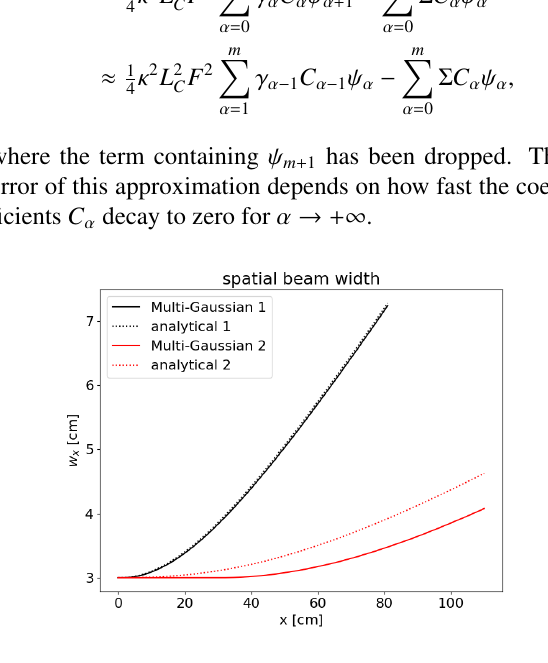
Figure 2. Evolution of the spatial width w x of the beam along the propagation axis x = τ . Comparison of the multi-Gaussian solu- tion (26) and the analytical reference (10) for two sets of fluctu- ation parameters. Beam parameters: initial width w x (0) = 3cm, initial curvature radius 1 / R 0 → 0, beam frequency f = 140GHz. First (second) set of fluctuation parameters: fluctuation layer width τ F = 1cm (30cm), fluctuation strength F = 0 . 05 (0 . 003), correlation length L C = 1cm (1cm).